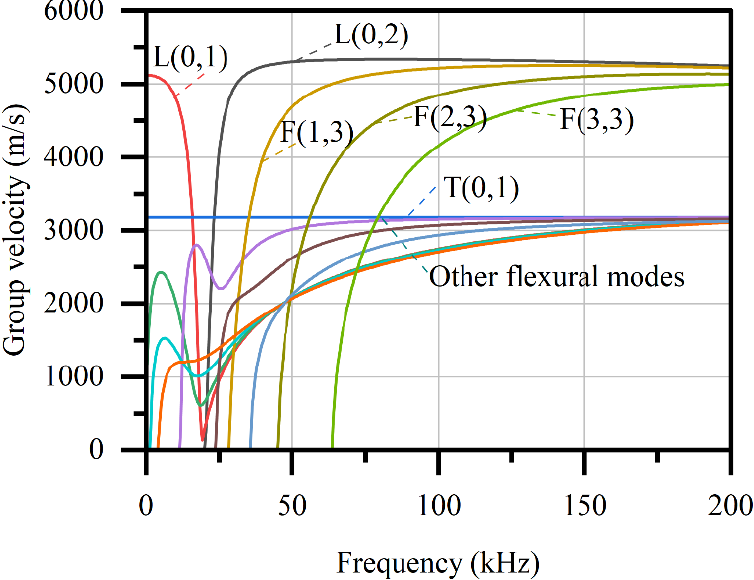
Figure 1. Dispersion curves of a typical steel tube with diameter of 88.5 mm and thickness of 4 mm. For each mode, the group velocity varies with frequency, which is called frequency dispersion. It will naturally cause distortion of the wave packet in propagation. In the real world, the frequency may also be influenced by the environment or other factors, so the wave velocity changes as